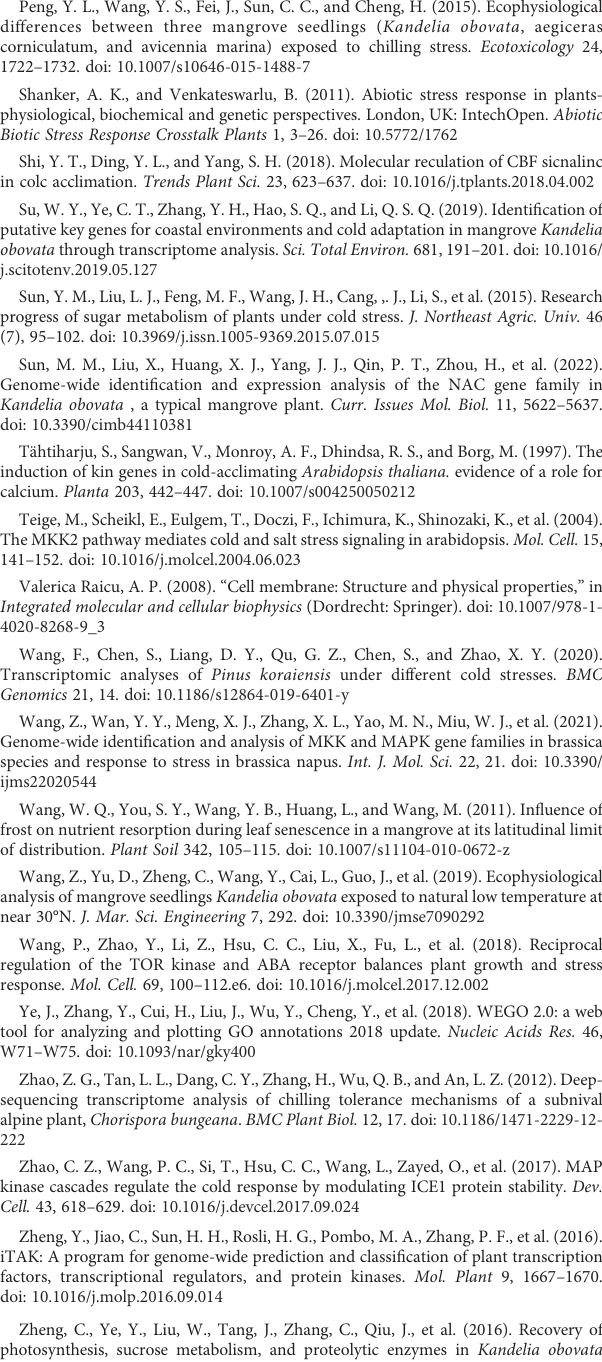
Figueroa, C. M., Lunn, J. E., and Iglesias, A. A. (2021). Nucleotide-sugar metabolism in plants: the legacy of Luis f. leloir. J. Exp. Botany 72, 4053 – 4067. doi: 10.1093/jxb/